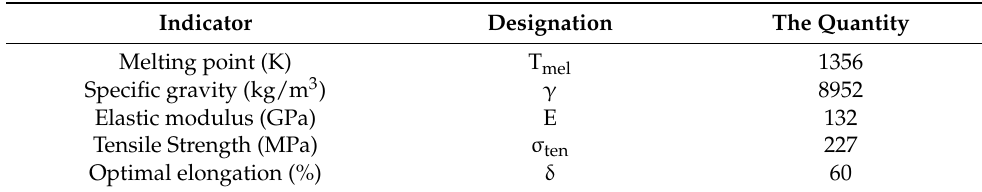
Table 10. Mechanical properties of M1